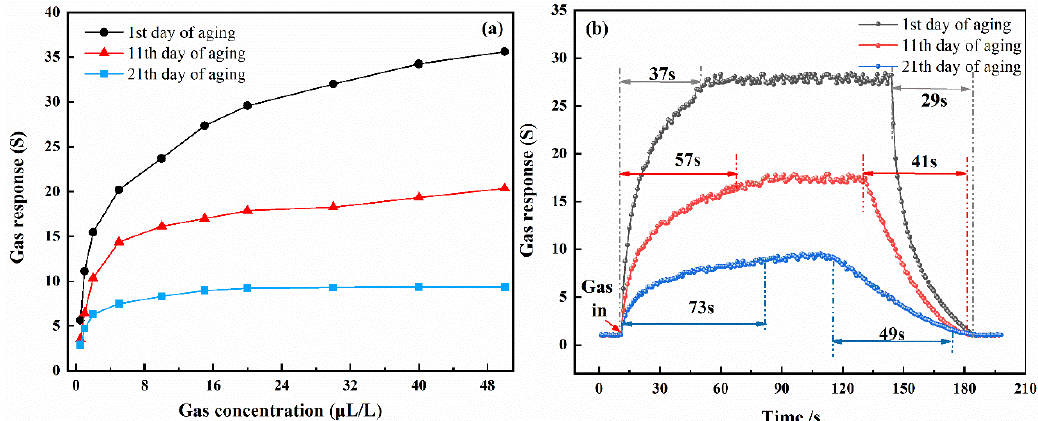
Figure 13. ( a ) Concentration characteristic curves of sample S3 under different aging time. ( b ) Dynamic response–recovery characteristic curve of S3 sample under different aging time.